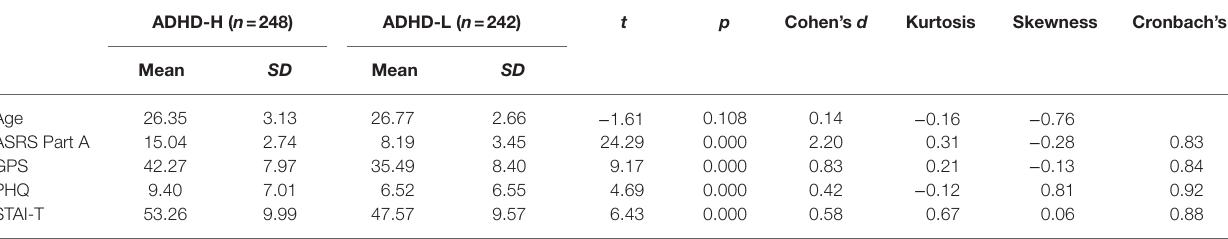
TABLE 1 | Sample characteristics and descriptive statistics for all analytic variables. ADHD-H ( n = 248)